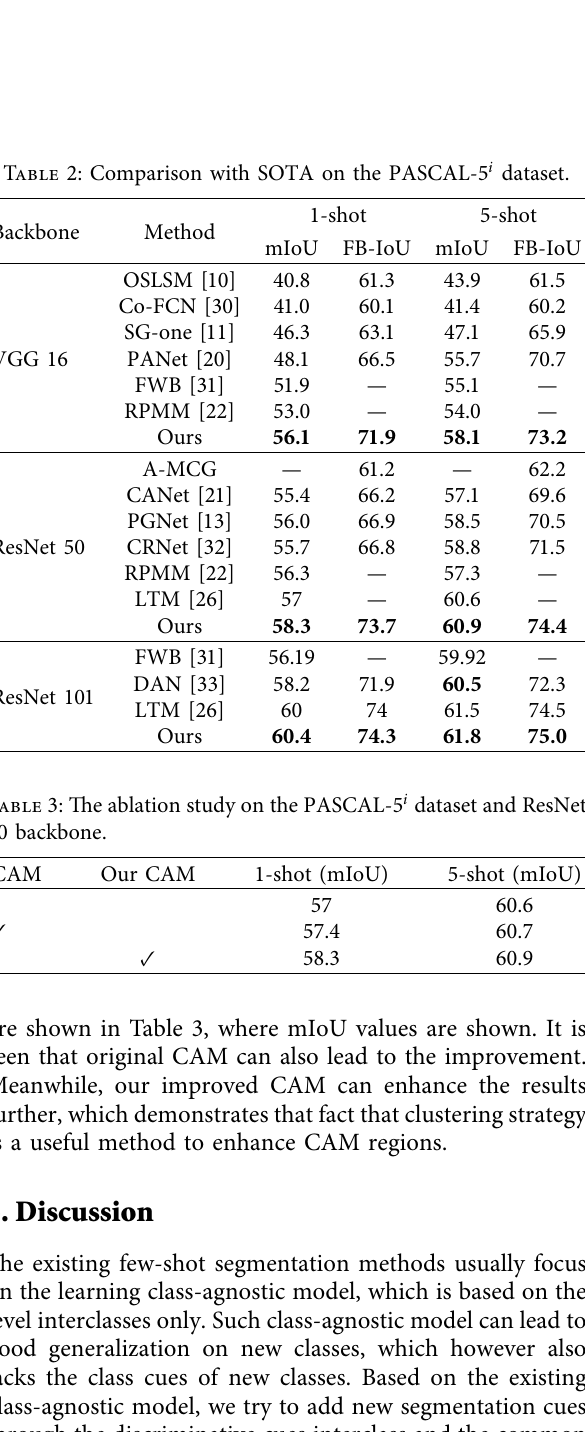
Table 2: Comparison with SOTA on the PASCAL-5 i dataset. Backbone Method